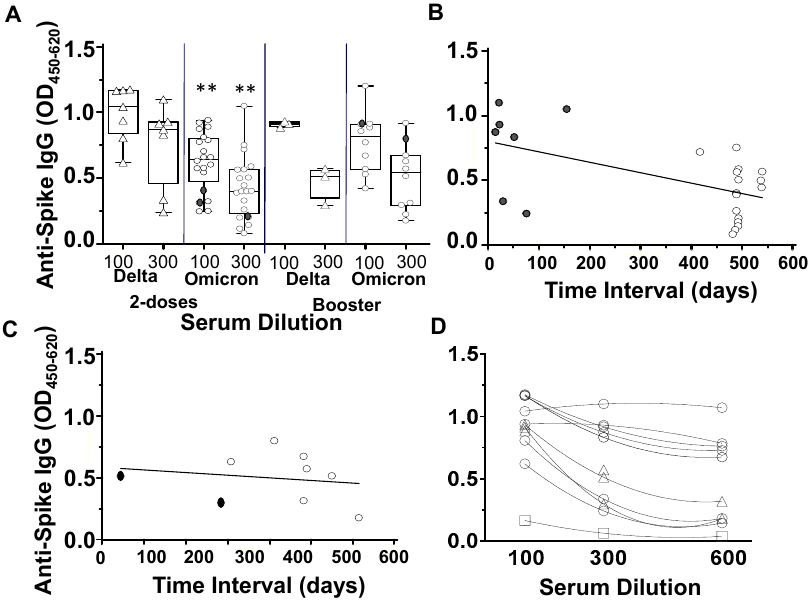
Figure 3. Anti-spike protein IgG reactivity 210 to 240 days POCS follow-up. Horizontal axis is either the serum dilutions ( A , D ) or the time intervals between serum sampling and last vaccination ( B , C ) The Delta variant n = 11 (triangles) versus the Omicron variant n = 30 (circles). Three Omicron cases reported a second natural infection 60 to 180 days prior to the serum sampling, bold circle ( A ). Linear regression of the anti-S-protein IgG reactivity, OD 450nm − OD 620nm at 1:300 serum dilution, from the Delta variant (closed circles) or Omicron variant infections (open circles) versus the time interval between the second vaccine dose and serum sampling; r = − 0.31 p < 0.01 ( B ) or time interval between the booster vaccine and serum sampling; r = − 0.03, p = 0.64 ( C ). Titers of anti-spike protein IgG in delta variant infections, n = 10; 1-dose (open rectangle), 2-doses (open circles) and booster (open triangles). Serum diluted 100-fold, 300-fold and 600-fold in Euroimmun Quant ELISA ( D ). ** p < 0.001 independent student t -test differences of the mean OD 450nm − OD 620nm IgG values Delta variant mean of 0.94 (95% CI 0.8–1.09) and mean 0.75 (95% CI 0.45–1.05) versus the Omicron variants’ mean of 0.65 (95% CI 0.57–0.74) and mean 0.43 (95% CI 0.32–0.54) at 1:100 and 1:300 dilutions, respectively.